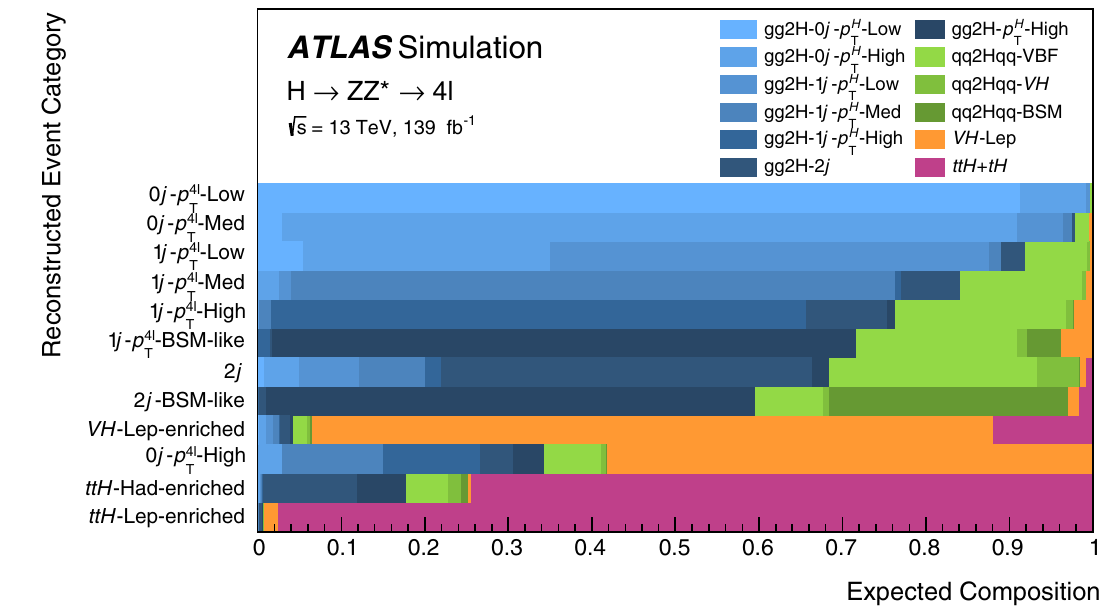
Fig. 3 Standard Model signal composition in terms of the Reduced Stage-1.1 production bins in each reconstructed event category. The bbH contributions are included in the ggF production bins Table 5 The input variables used to train the MLP, and the two RNNs for the four leptons and the jets (up to three). For each category, the processes which are classified by an NN, their corresponding input variables and the observable used are shown. For example, there are